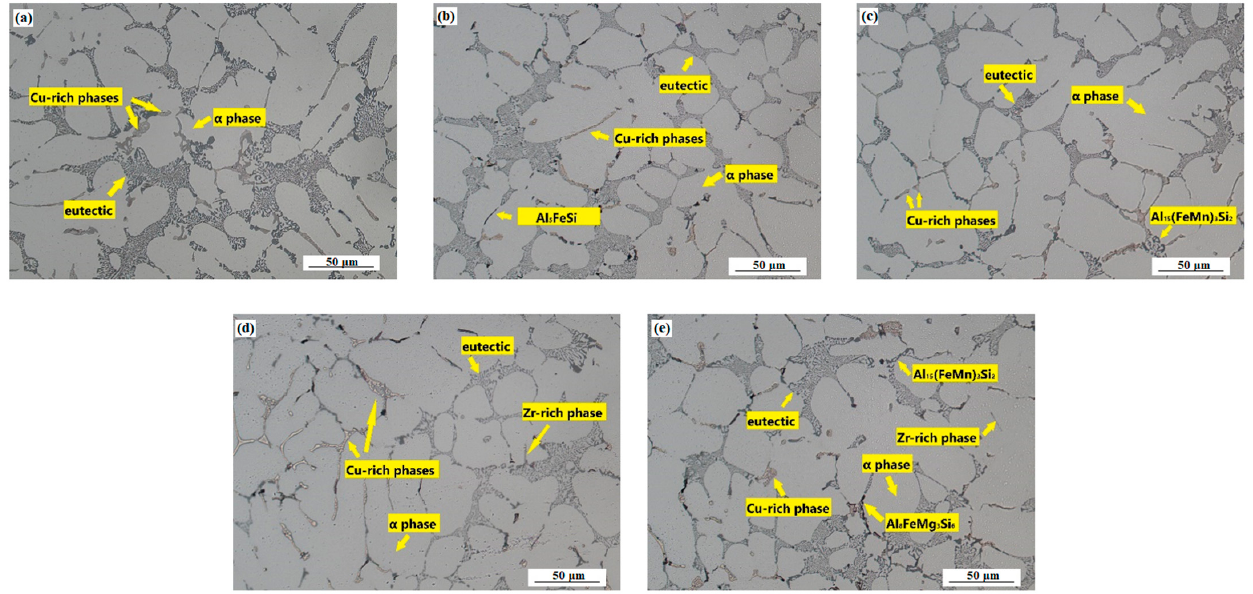
Figure 11. Microstructure of the experimental alloys AlSi5Cu2MgZrX (as ‐ cast, H 2 SO 4 etch.): addi ‐ tion of ( a ) 0 wt. % Zr; ( b ) 0.05 wt. % Zr; ( c ) 0.10 wt. % Zr; ( d ) 0.15 wt. % Zr; ( e ) 0.20 wt. % Zr .